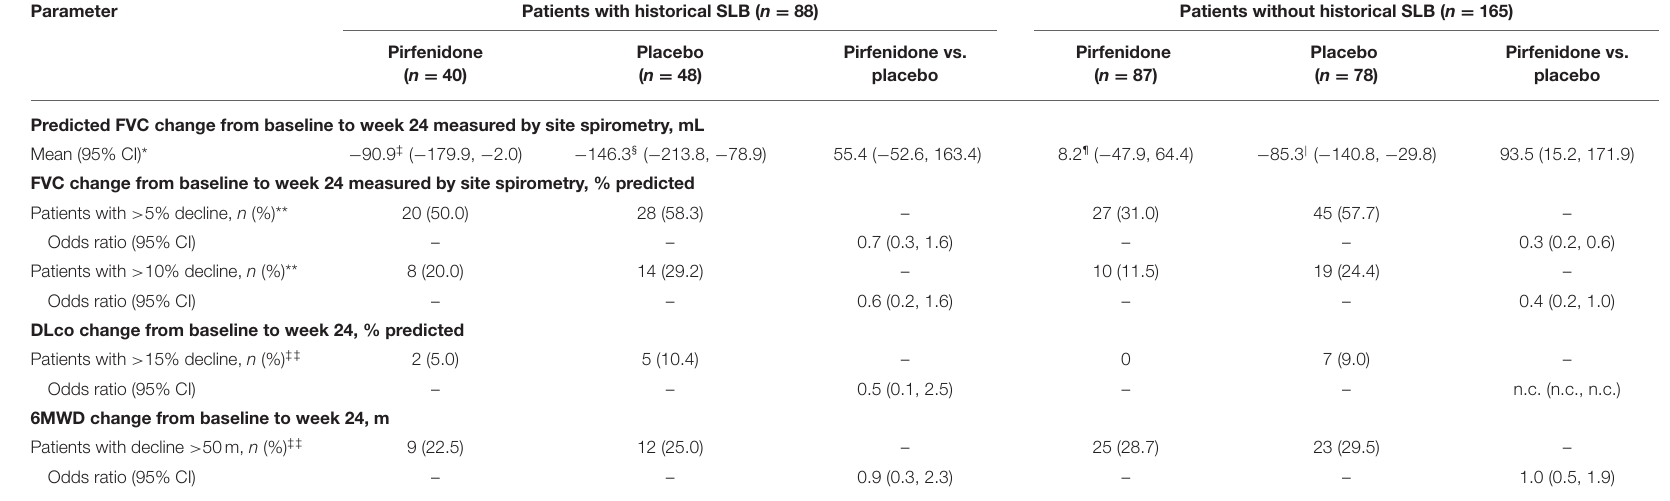
TABLE 2 | Summary of post-hoc efficacy endpoints to week 24 in patients in the pirfenidone in uILD study analyzed by SLB status. Parameter Patients with historical SLB ( n = 88) Patients without historical SLB ( n = 165)